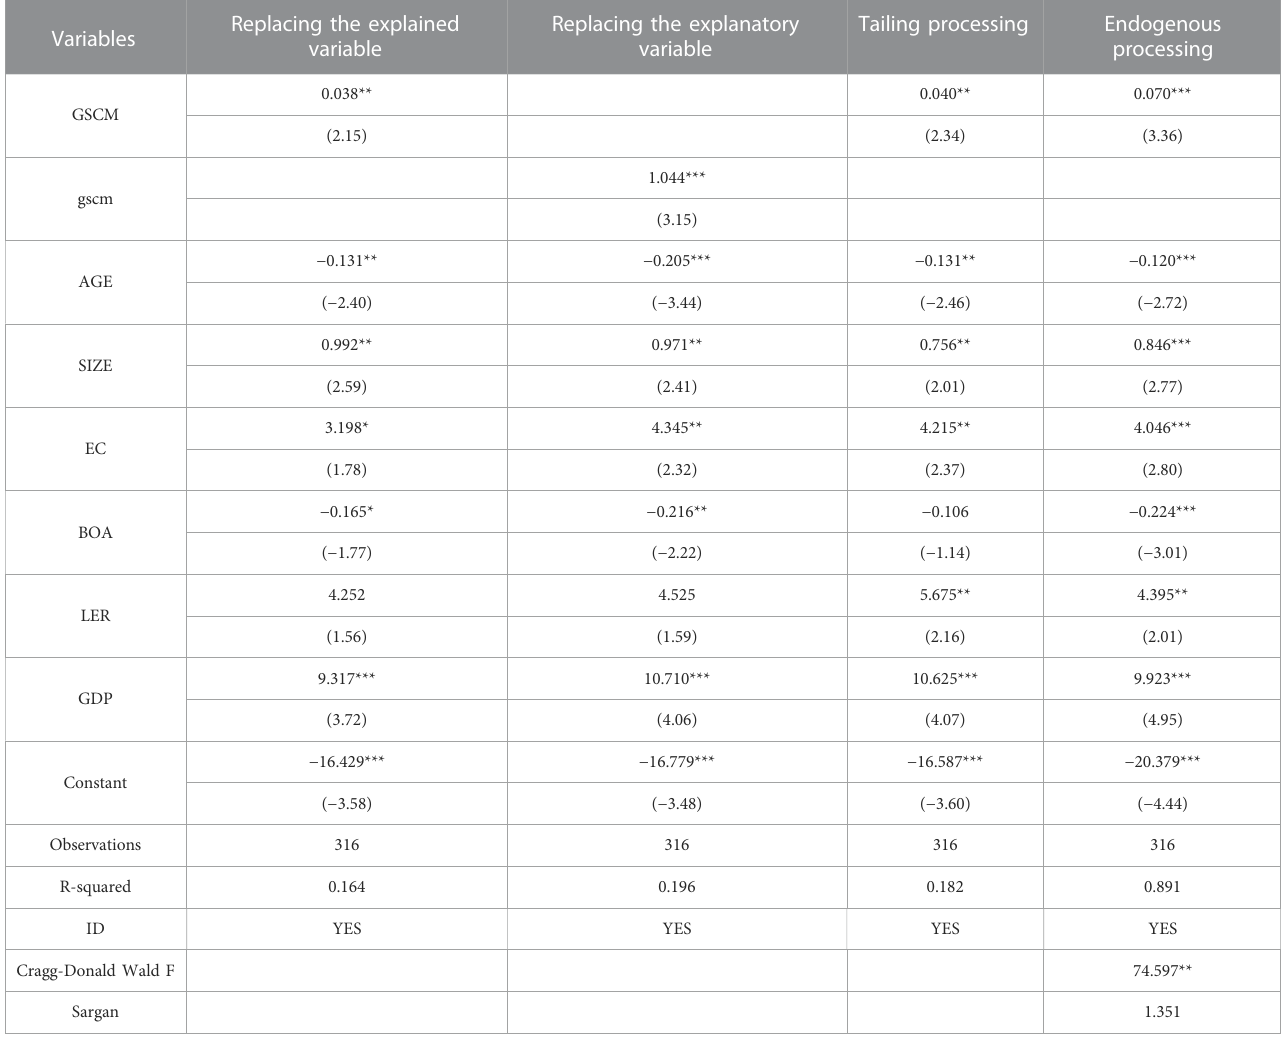
TABLE 3 Robustness